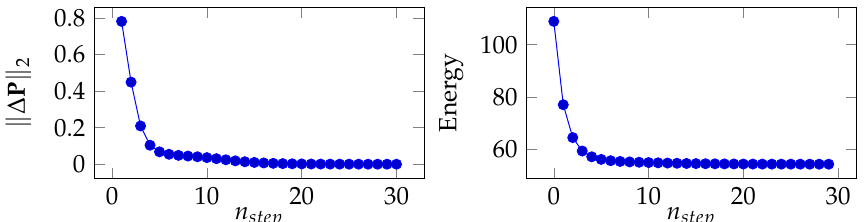
Figure 6. Convergence of BMS (1-shot on miniImagenet). ( left ) (cid:107) ∆ P (cid:107) 2 as a function of n step . ( right ) En- ergy (1-shot on miniImagenet) as a function of n step .